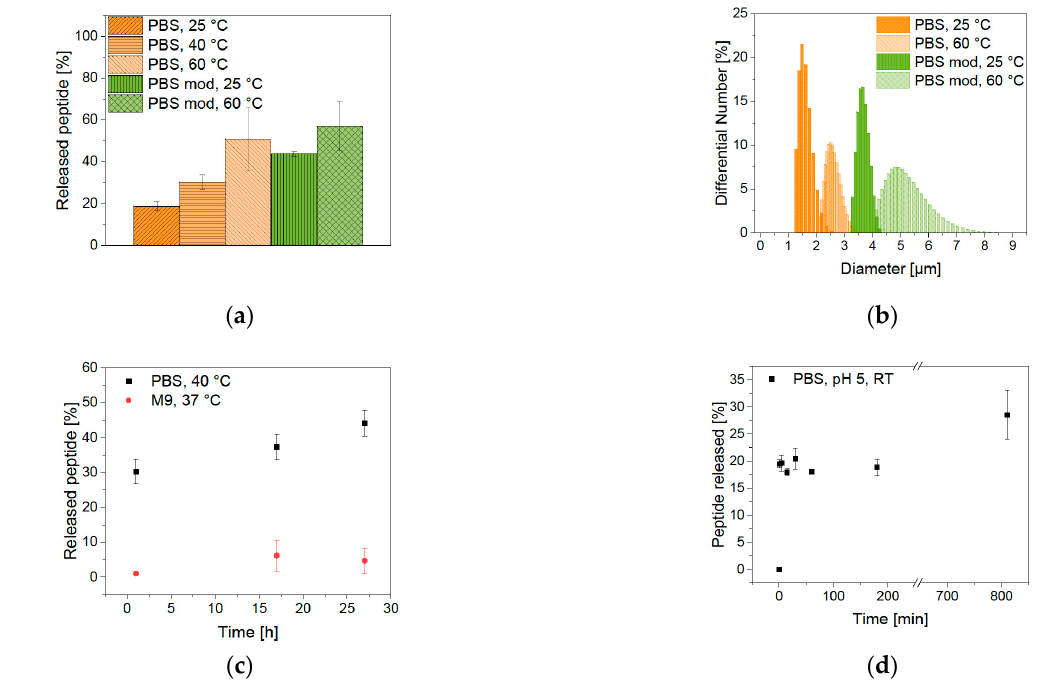
Figure 7. ( a ) Desorption of LL from BIONs at different conditions after one hour, ( b ) agglomeration behavior after one hour of elution at different conditions, ( c ) desorption depending on the time, and ( d ) kinetic of the desorption process of LL in 50 mM PBS, pH 5, and room temperature.